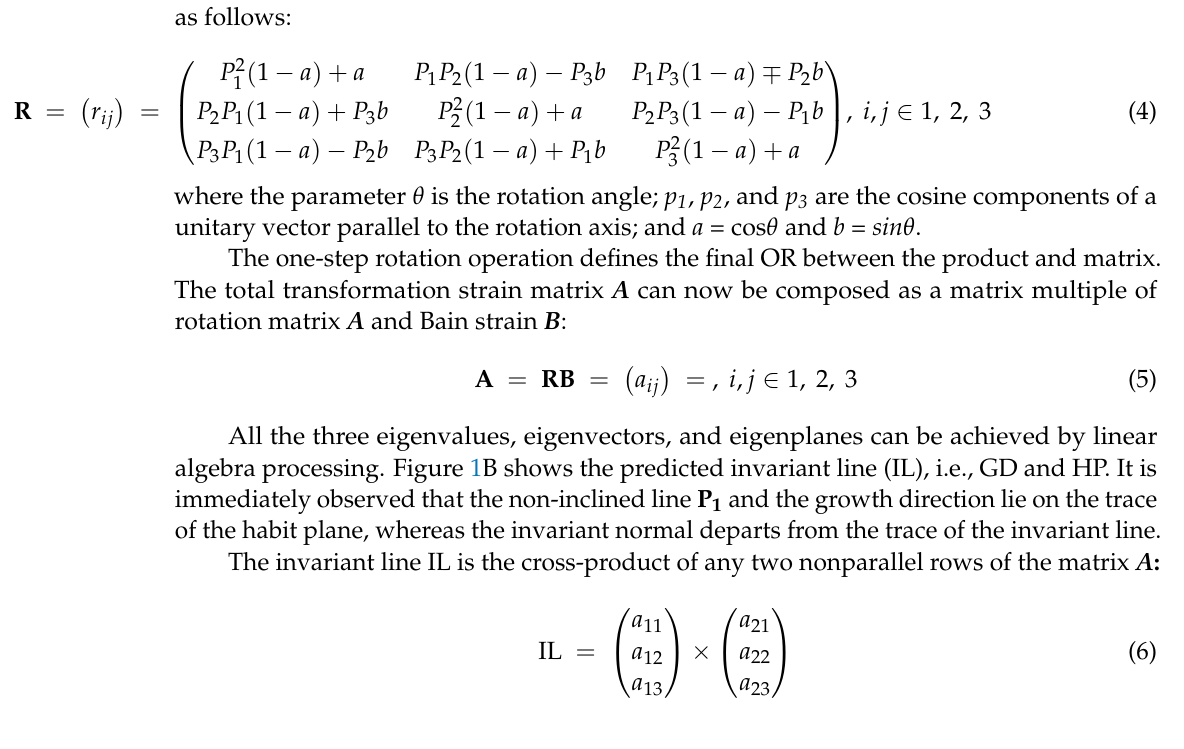
Figure 1. Scheme of IDE model showing the constraint of one-step rotation in diffusional phase transformation. ( A ) 3D model giving non-inclined line P 1 , invariant normal Q 1 , and the deformed lines P 2 and Q 2 . They separately attach on the surface of blue and green cones. ( B ) Stereographic projection presenting geometric configuration of all vectors, predicted growth direction (IL), habit plane (HP), and their traces.